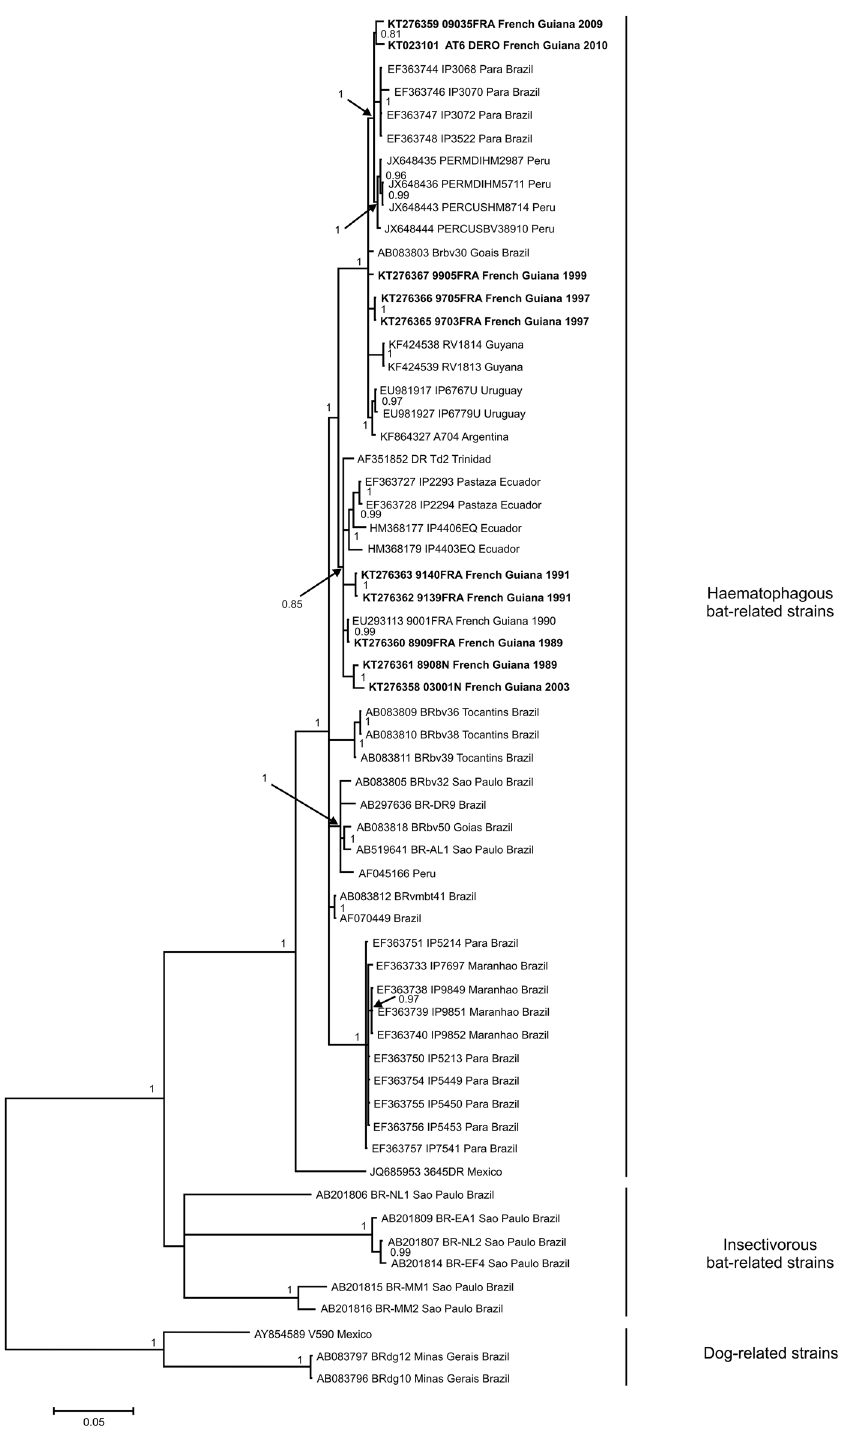
Fig 2. Phylogenetic tree constructed using Bayesian methods based on 1314 nucleotides of the nucleoprotein gene. Virus names are associated with their accession numbers. Novel sequences generated from the two rabid bats in this study are shown in bold. Support for nodes is provided by the posterior probabilities of the corresponding clades. All resolved nodes have a posterior probability greater than 0.8. Scale bar indicates nucleotide sequence divergence among